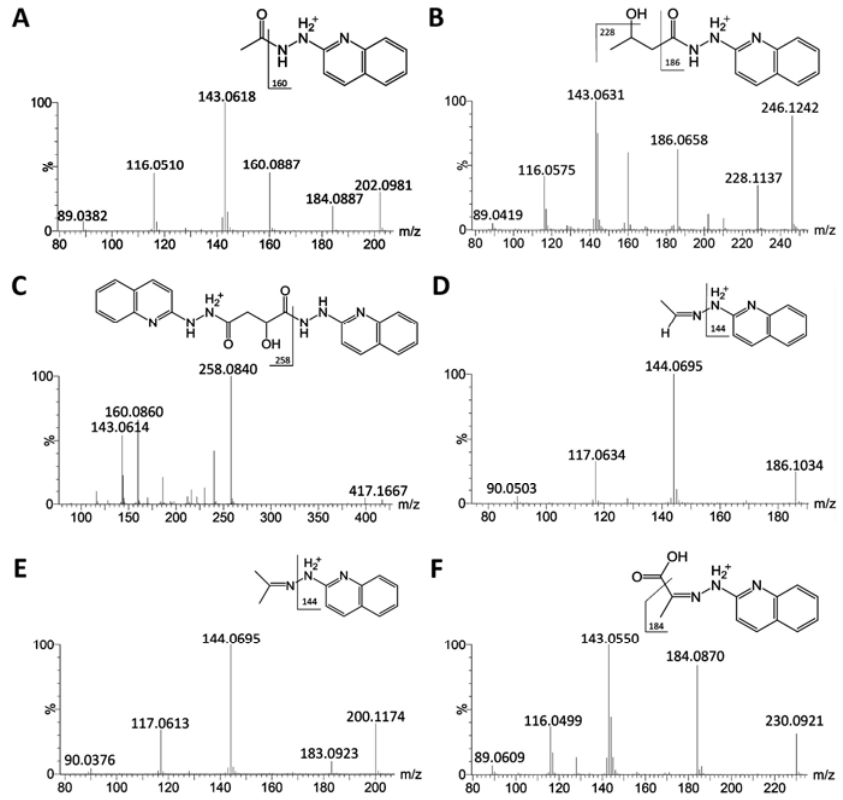
Figure 2. MS/MS spectra of HQ derivatives. ( A ) Acetate-HQ derivative; ( B ) HBA-HQ derivative; ( C ) malate-HQ derivative; ( D ) acetaldehyde-HQ derivative; ( E ) acetone-HQ derivative; ( F ) pyruvate-HQ